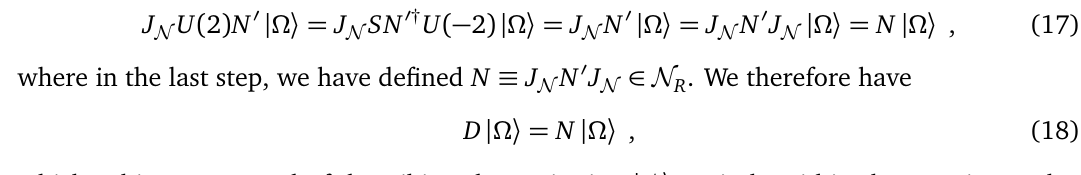
Figure 2: Same as the right panel of fig. 1, but with a greatly exaggerated shift in the horizon for illustration. N with red lines. Note that N (cid:48) right symmetry. The figure also illustrates the fact that N The behind-the-horizon region D N , is shaded R